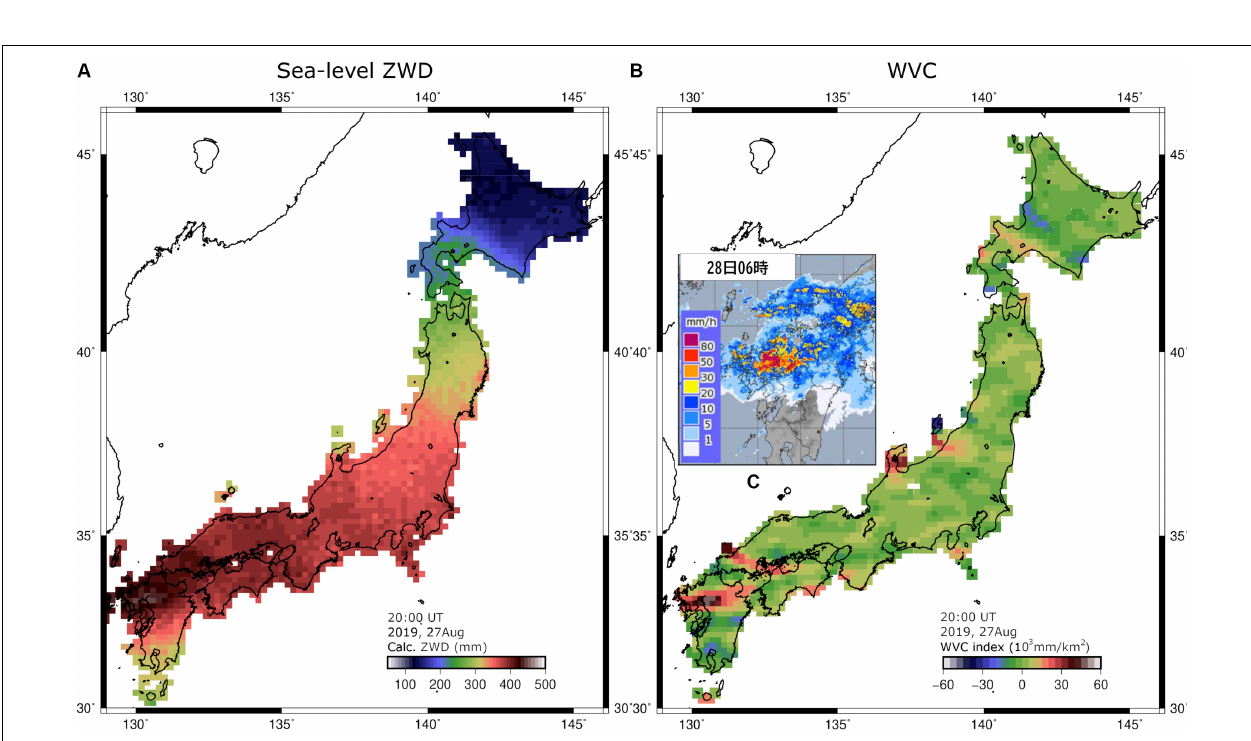
FIGURE 7 | Estimated sea-level ZWD (A) and WVC index (B) at 20 UT (05 JST) on August 27 (August 28 in JST), 2019. (C) shows the rain rate map from Japan Meteorological Agency [JMA] (2019) at the epoch 1 h later (21UT) than (A,B) .